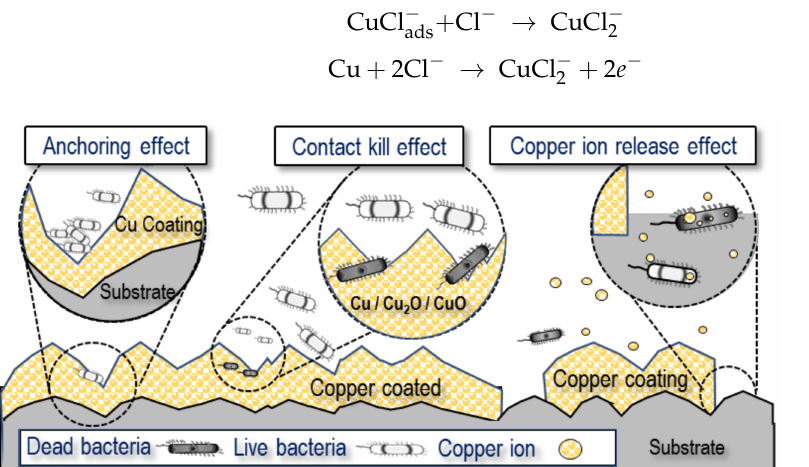
Figure 9. Schematic of the antimicrobial activity mechanism of copper coating specimens with super-spread wetting